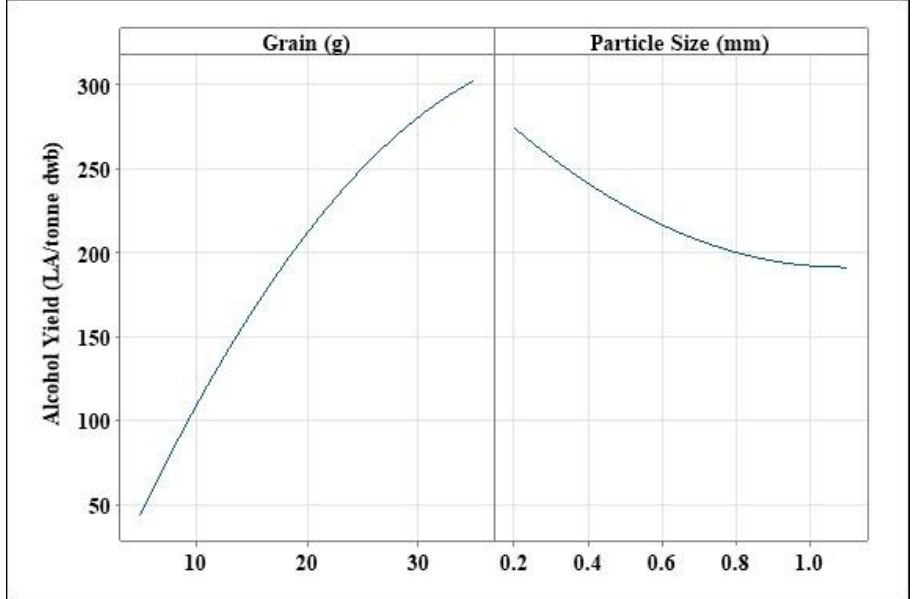
Figure 5. Main effect plot for both independent variables used within this study. Gain amounts show a positive polynomial graph, showing alcohol yield increases as grain amount increases, while alcohol yield is shown to decrease as grain particle size increases at a linear rate.